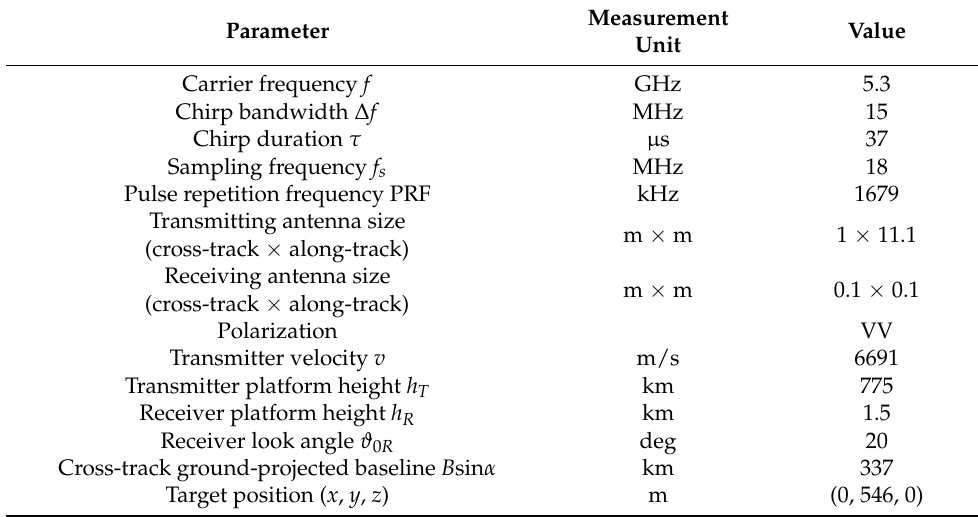
Table 2. System parameters of the one-stationary bistatic SAR configuration considered in the simulations.